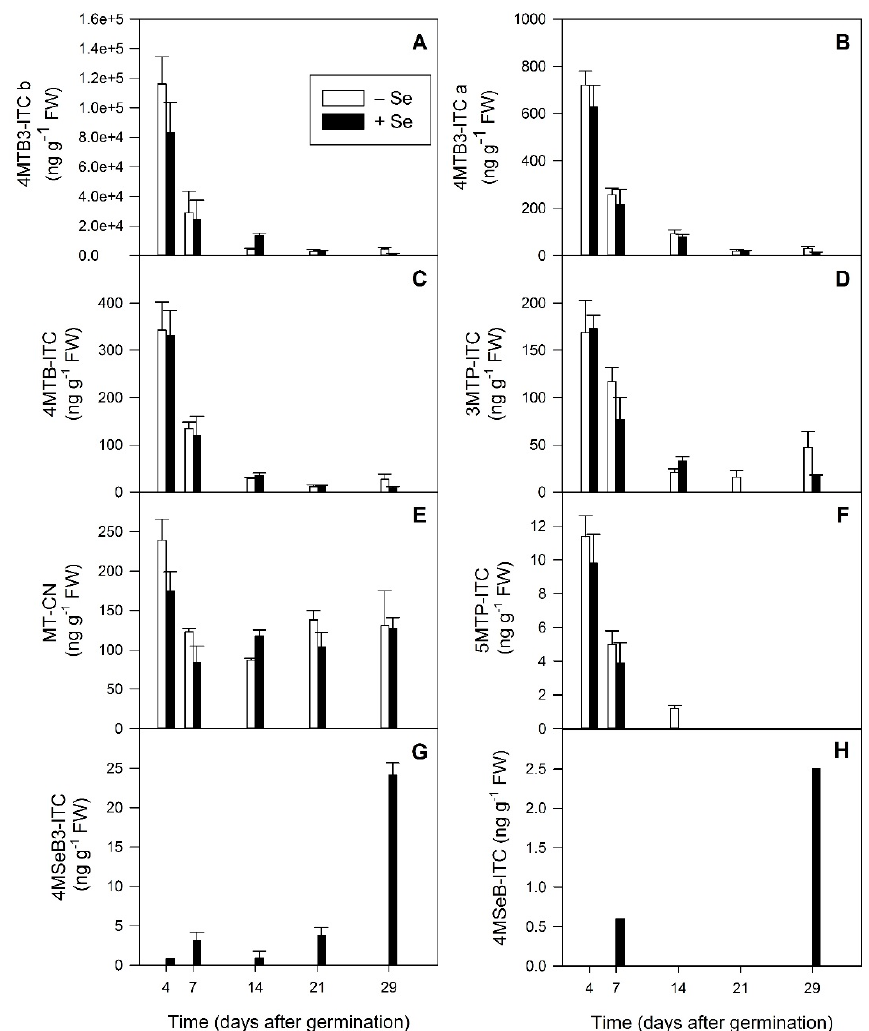
Figure 8. Isothiocyanate and nitrile glucosinolate breakdown products detected using GC-MS analysis of five developmental stages (4, 7, 14, 21 and 29 days after germination) of Raphanus sativus plants grown hydroponically in the absence (white bars) and presence (black bars) of 40 µM sodium selenate. Each bar represents the mean value of three biological replicates, n = 3. Error bars represent the standard error of the mean. ( A ) 4MTB3-ITC b: 4-(methylthio)but-3-enyl isothiocyanate isomer b, ( B ) 4MTB3-ITC a: 4-(methylthio)but-3-enyl isothiocyanate isomer a, ( C ) 4MTB-ITC: 4-